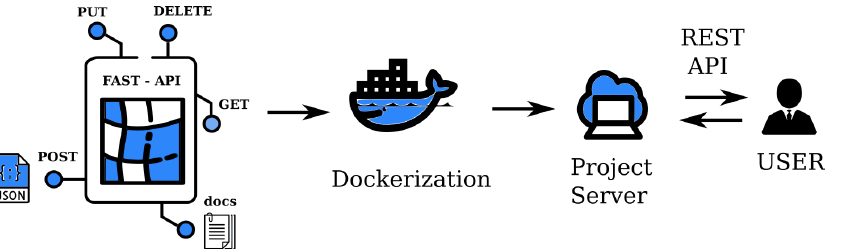
Figure 3. Deployment of the containerized parametric FEM calculation using a DT as a standard- ized